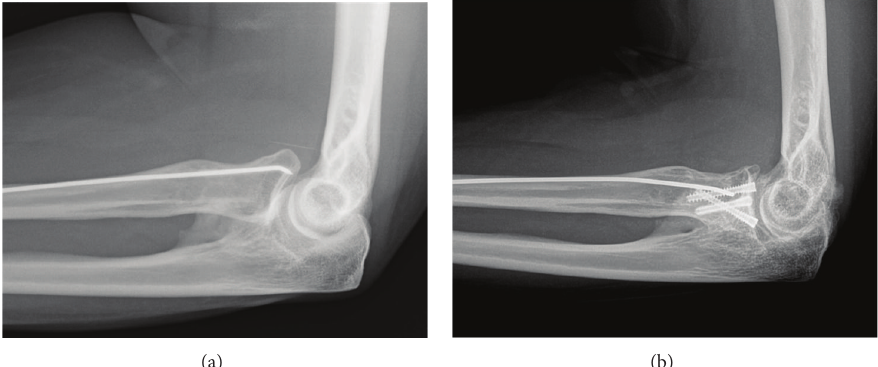
Figure 2: (a) Preoperative lateral X-ray showing the radial neck malunion of 60 ∘ dorsal angulation. (b) Postoperative X-ray showing the radial neck osteotomy and fixation.